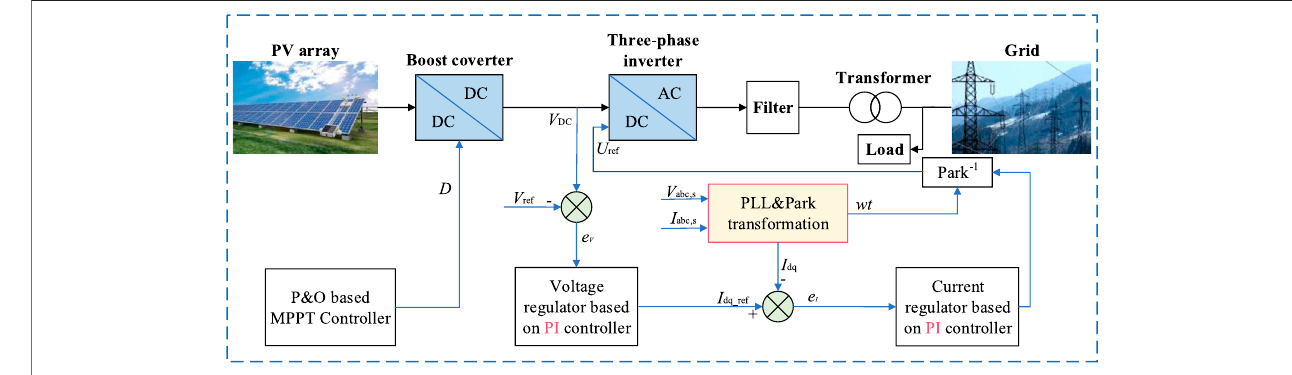
FIGURE 1 | The structure of the 250 kW PV system.